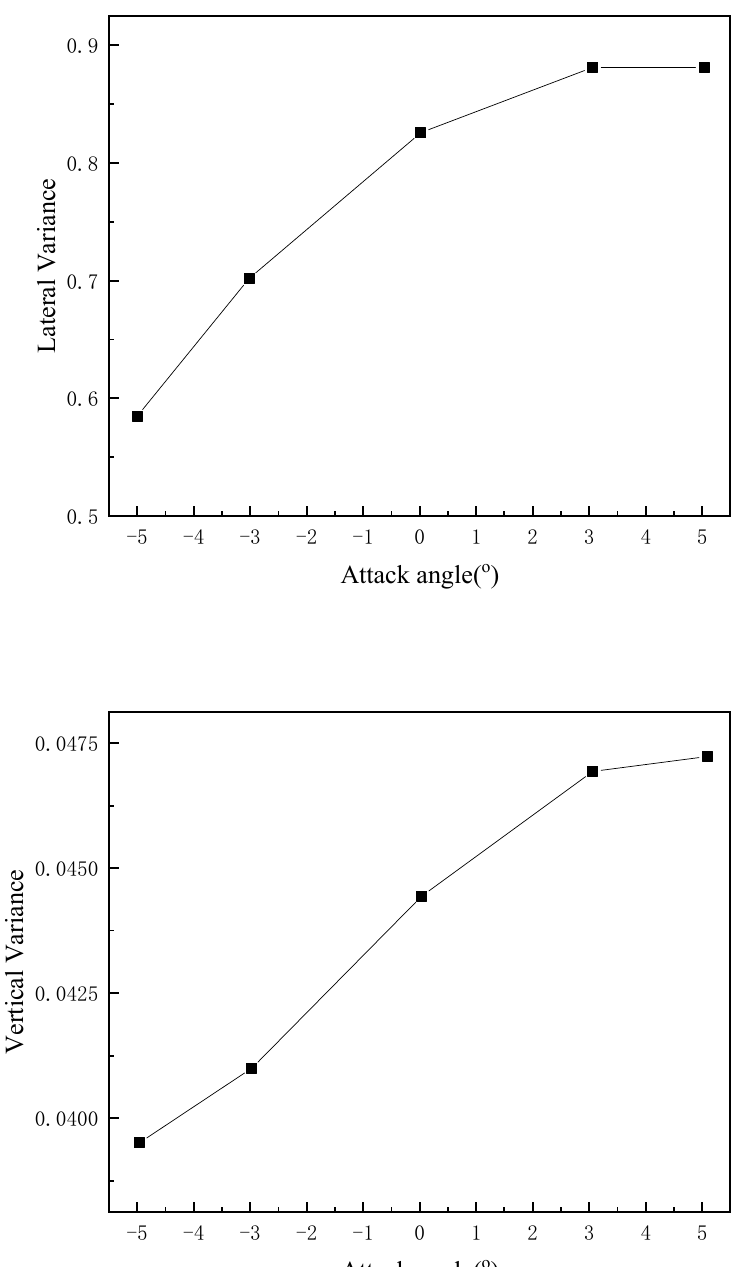
Figure 8. The variance of responses of the bridge deck with different attack angle.